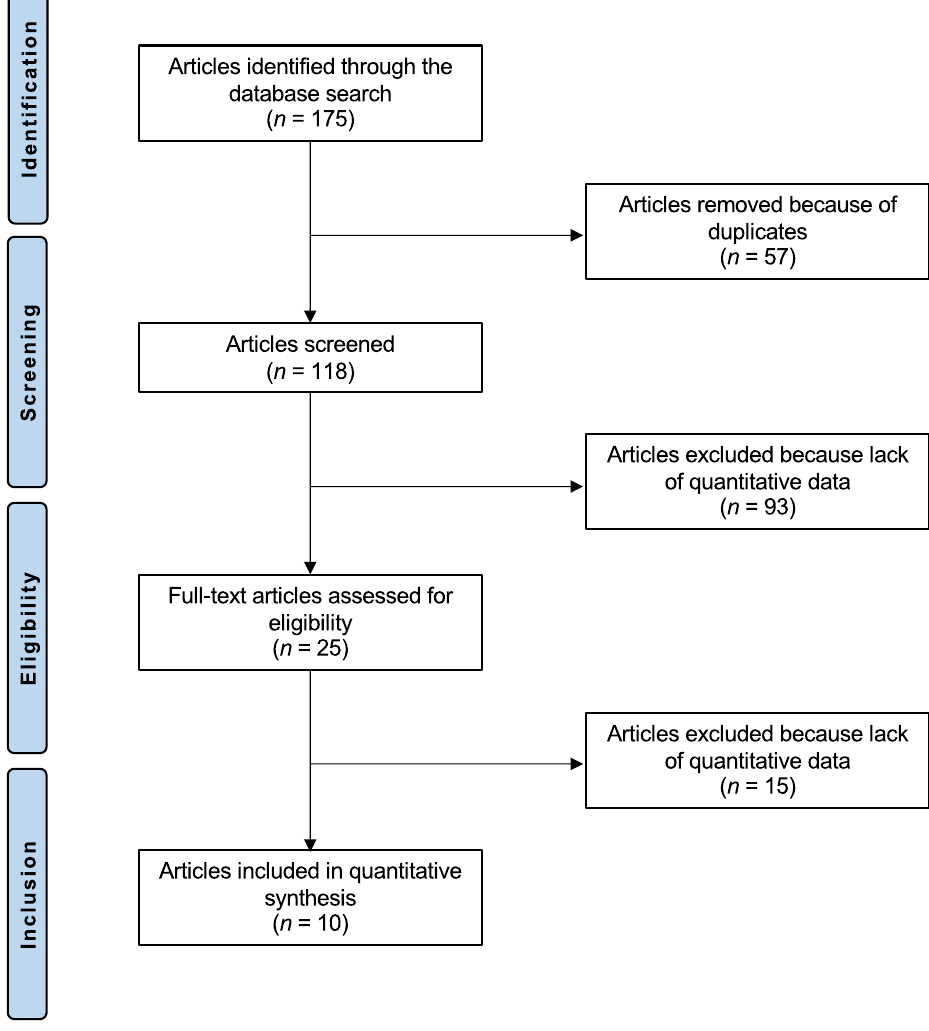
Figure 1. Flow chart of the literature